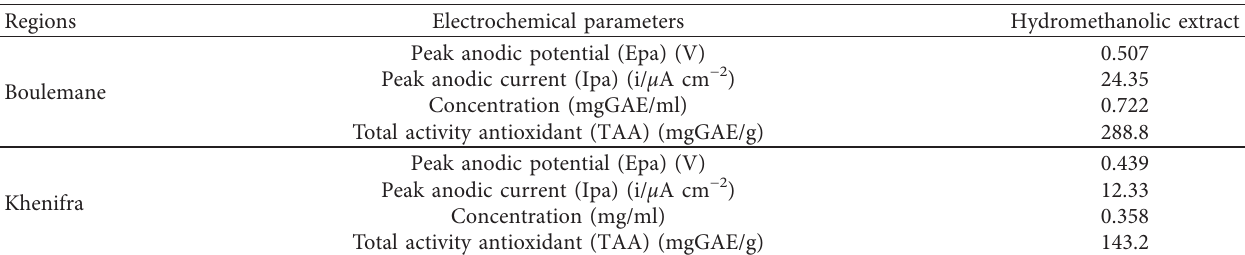
Figure 4: Cyclic voltammograms of the Salvia officinalis hydromethanolic extract from Boulemane and Khenifra regions. Table 3: Electrochemical parameters and total antioxidant activity of the hydromethanolic extract of Salvia officinalis L (0.1mg/mL) for two